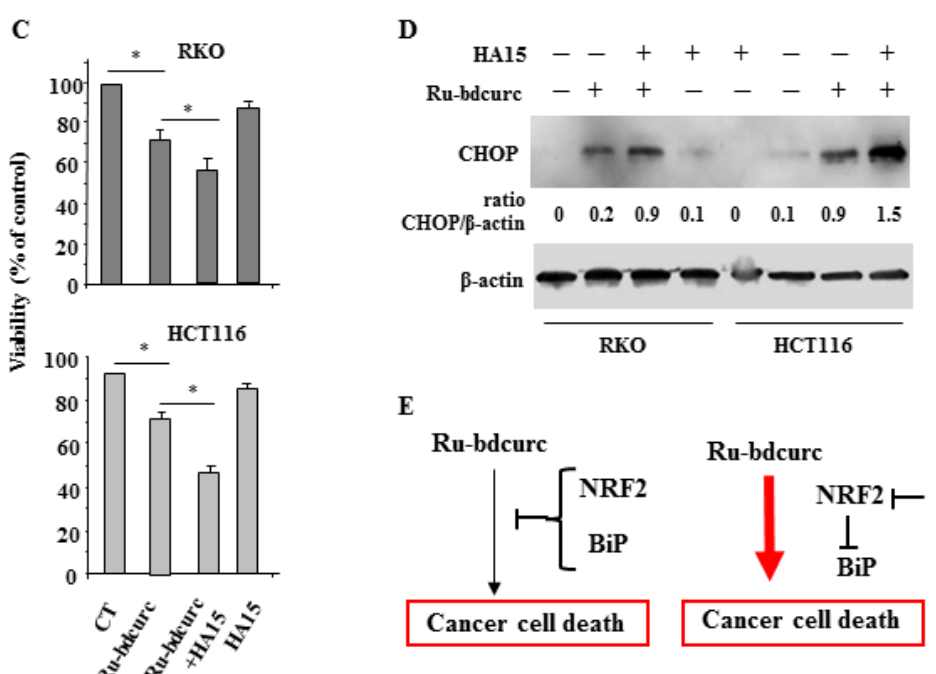
Figure 5. Inhibition of NRF2 or BiP increases the Ru-bdcurc cytotoxic effect in colon cancer cells. ( A ) RKO and HCT116 colon cancer cells were left untreated or pre-treated with 100 µM brusatol (Brus) for 4 h and then treated with 100 µM Ru-bdcurc for 24 and 48 h, before cell proliferation was measured by XTT assay. ( B ) Cell viability of RKO and HCT116 cells pre-treated with 100 µM brusatol (Brus) for 4 h and then treated with 100 µM Ru-bdcurc for 24 was measured by Trypan blue exclusion assay. ( C ) Cell viability of RKO and HCT116 cells, pre-treated with 10 µM HA15 for 1 h and then treated with 100 µM Ru-bdcurc for 48 h, was measured by Trypan blue exclusion assay. * p ≤ 0.05. ( D ) Western blot analysis of CHOP in RKO and HCT116 colon cancer cells pre-treated with 10 µM HA15 for 1h and the treated with 100 µM Ru-bdcurc for 48 h. β -actin was used as protein loading control. The ratio of the proteins level vs . β -actin, following densitometric analysis, is reported in the right panels. ( E ) Schematic summary of the negative effect of NRF2 and BiP pathways on Ru-bdcurd cytotoxic effect (left panel); inhibition of NRF2 also inhibits BiP and improves the Ru-bdcurc-induced cell death (right panel).